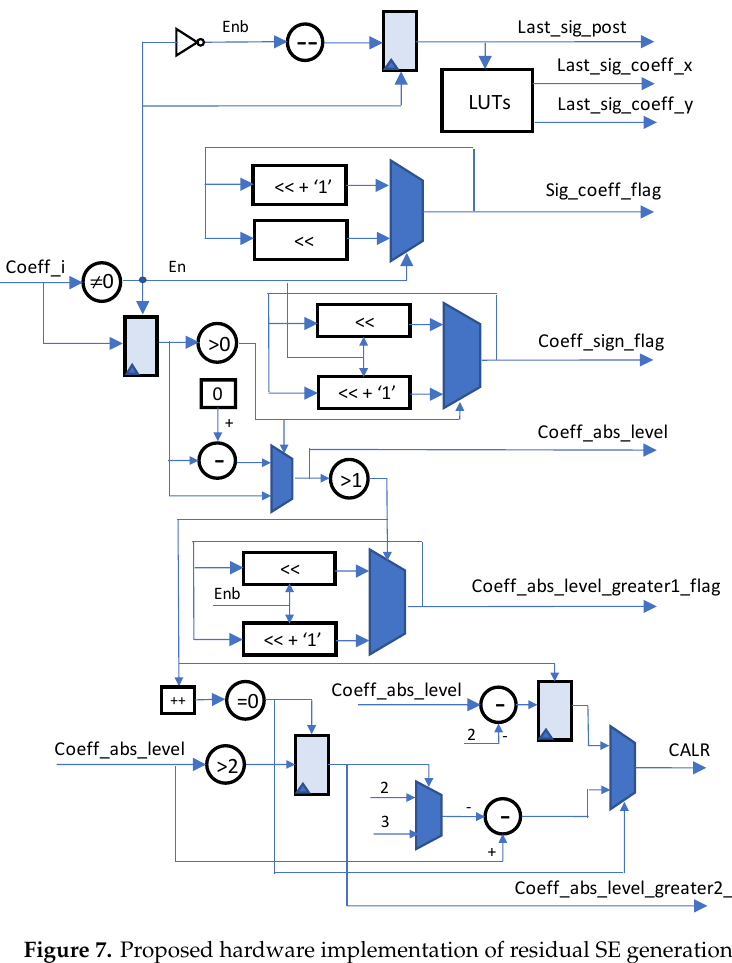
Figure 7. Proposed hardware implementation of residual SE generation.